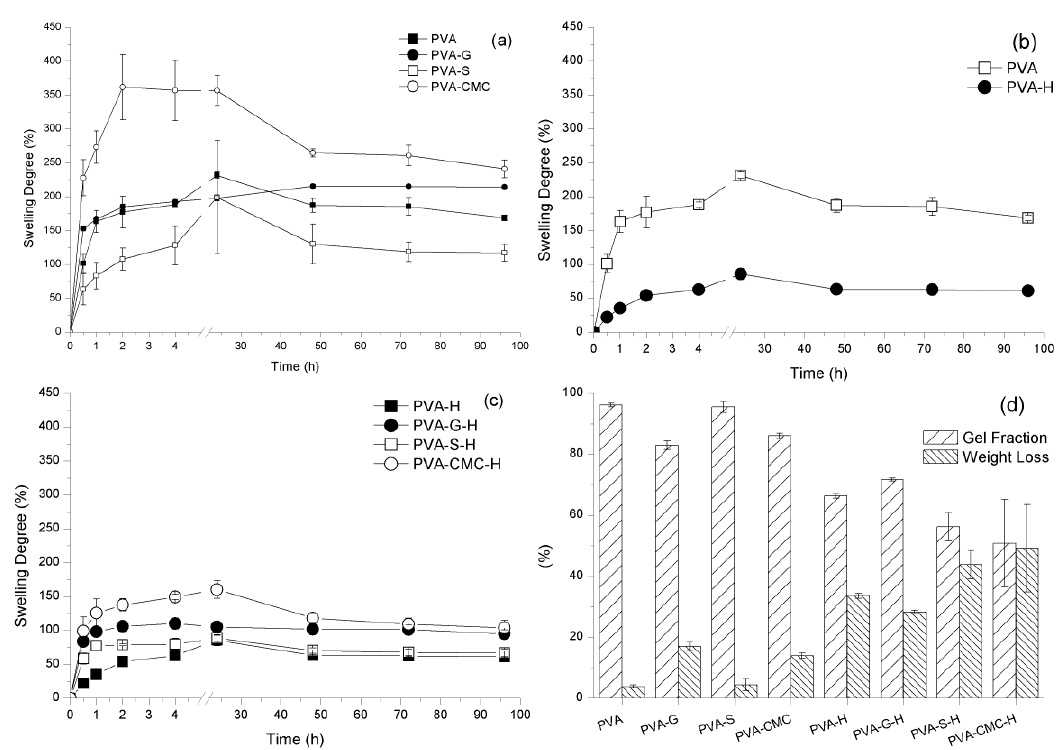
Figure 3. Sample swelling degree (a – c); sample degradation and gel fraction (d).